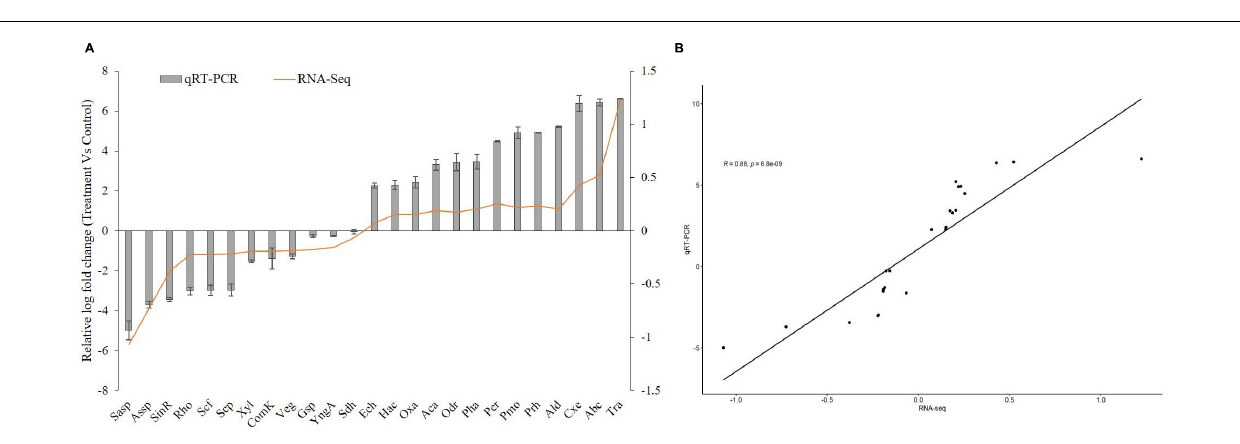
77.3 ◦ to 55.8 ◦ of the PET film after 90 days of bacterial